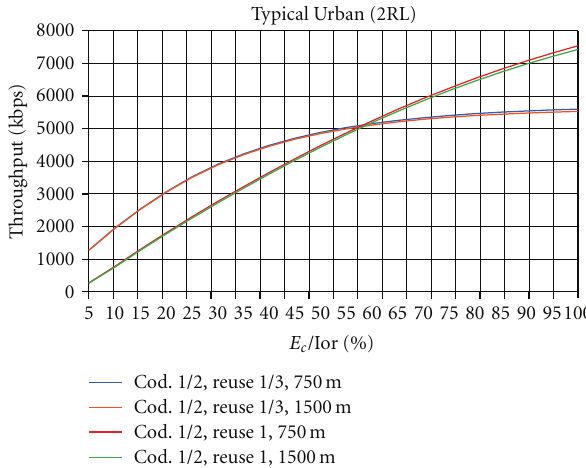
Figure 18: MIMO Throughput versus E c /Ior for SC-PTM, cod. 1 / 2.